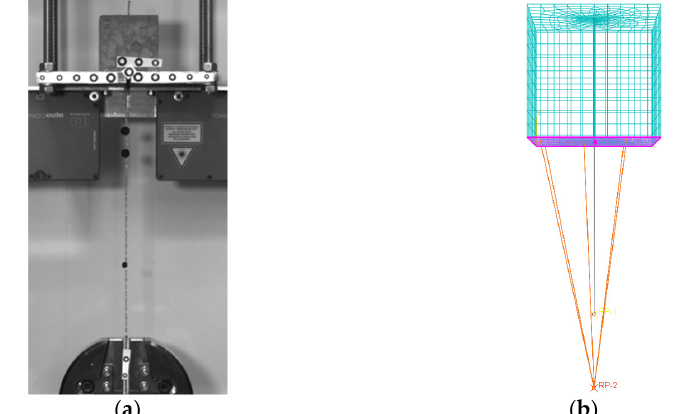
Figure 6. ( a ) Experimental set-up ‘HW-GLT’ system; ( b ) FE model and boundary conditions.